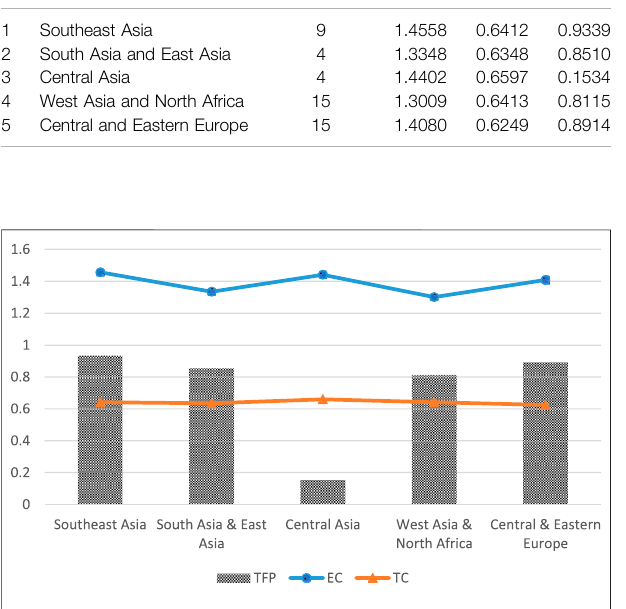
FIGURE 6 | Regional productivity